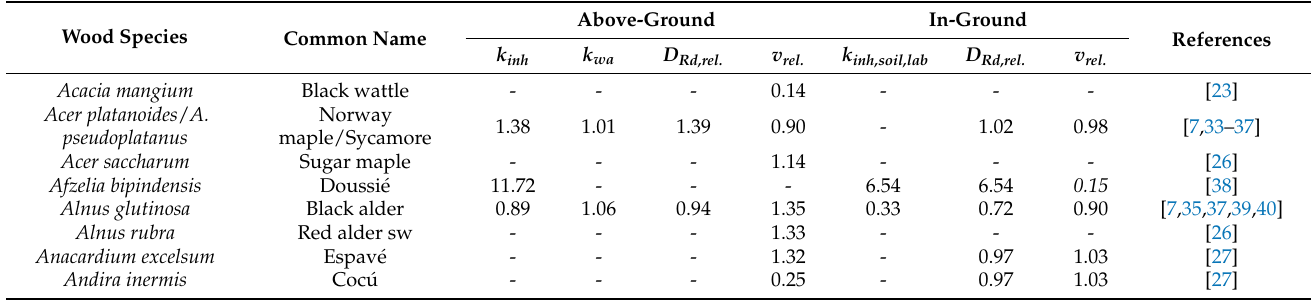
Table 1. Parameters for predicting the material resistance of untreated hardwoods in- and above-ground. k inh = factor accounting for protective inherent properties based on white rot, brown rot, and soil contact tests; k inh,soil,lab = factor account- ing for protective inherent properties based on laboratory test with soil contact and soft rot fungi; k wa = factor accounting for moisture performance (wetting ability); D Rd,rel. = relative resistance dose; v rel. = relative decay rate; sw = sapwood. Calculated v rel. in